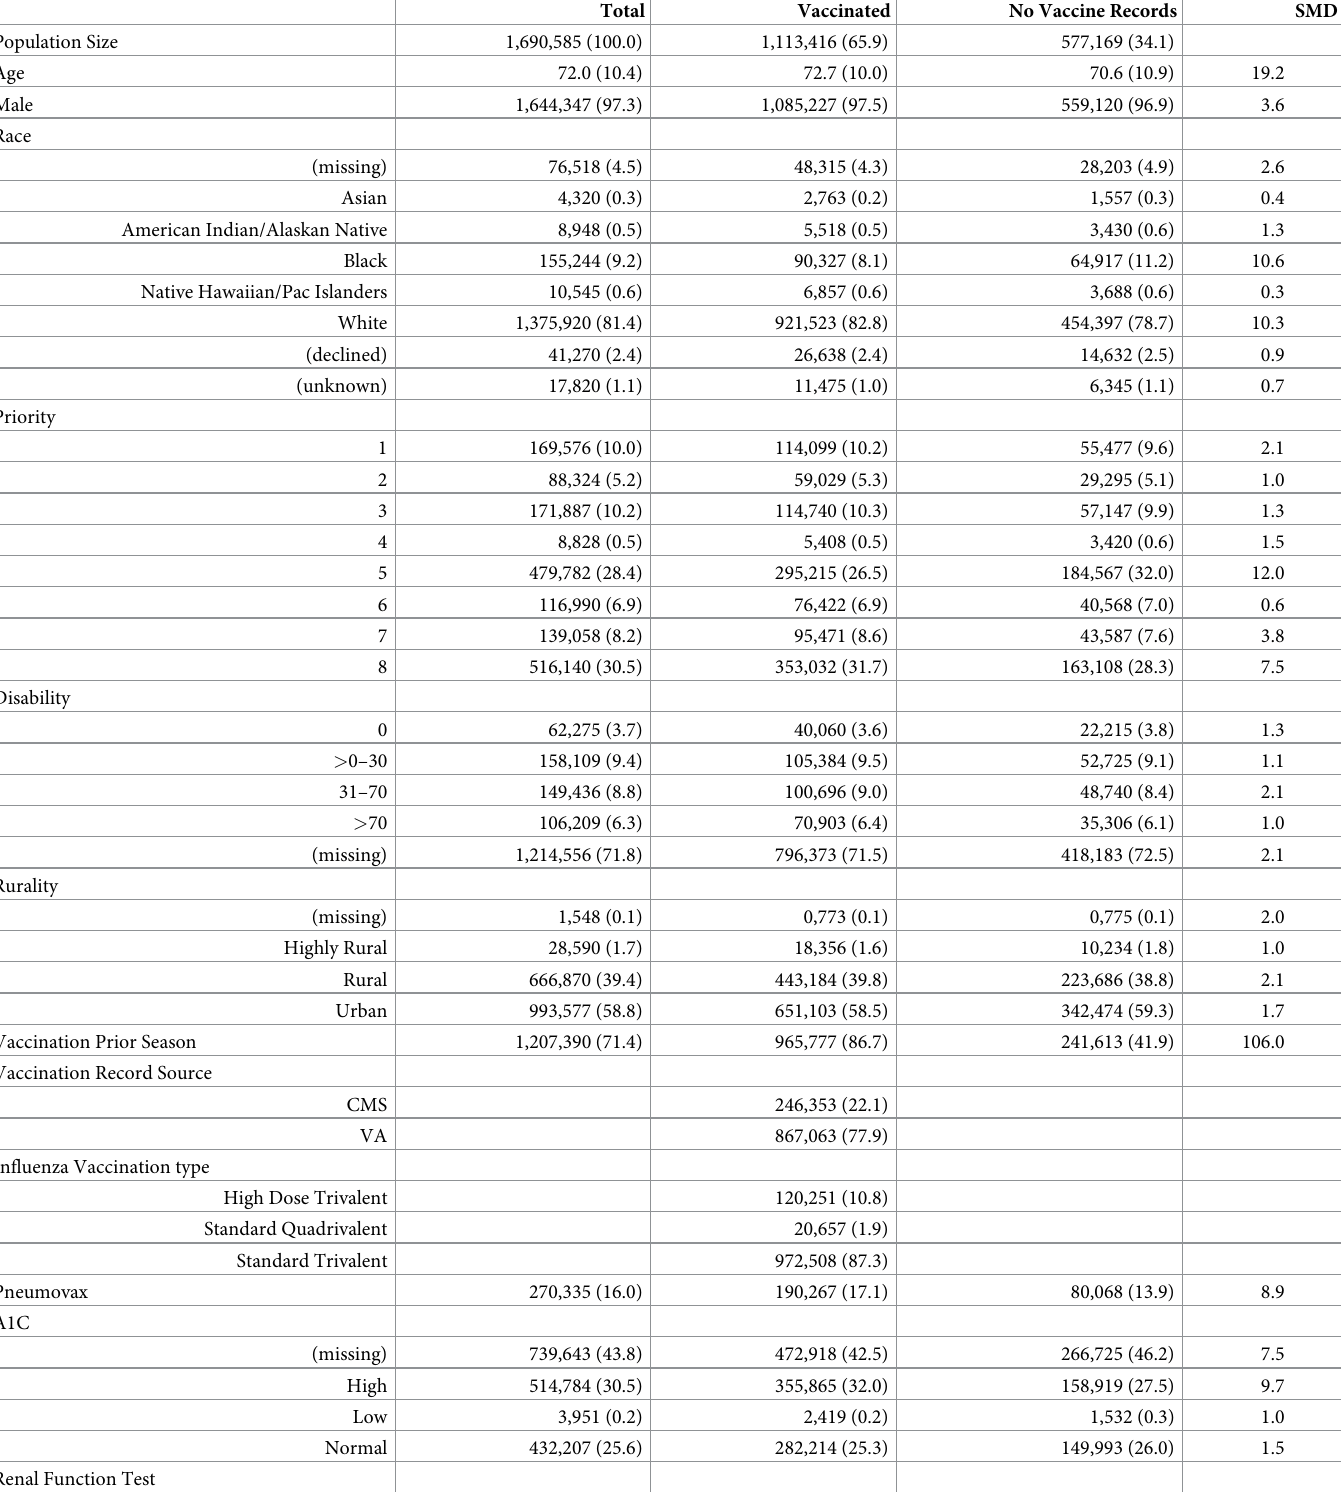
Table 2. Baseline characteristics by vaccination status—Study period